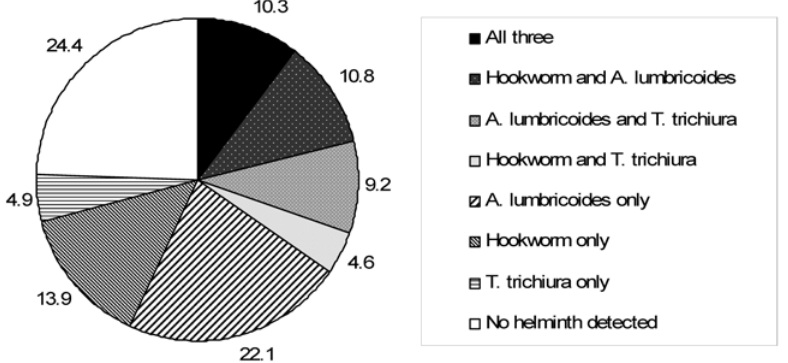
Figure 1. Prevalence (%) of geohelminth infections among 390 pregnant women, Gem, July 2003.